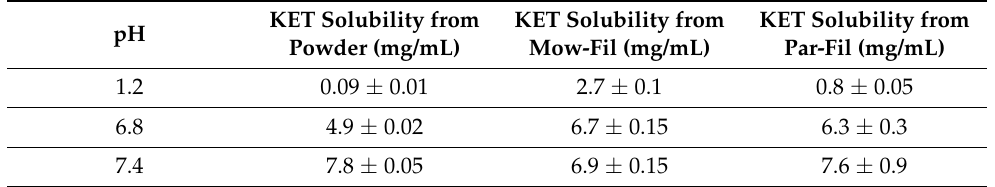
Table 3. Solubility of KET from API powder and API loaded filaments at pH 1.2, 6.8, and 7.4, expressed as mean saturation concentration (mg/mL) ± SD, n =